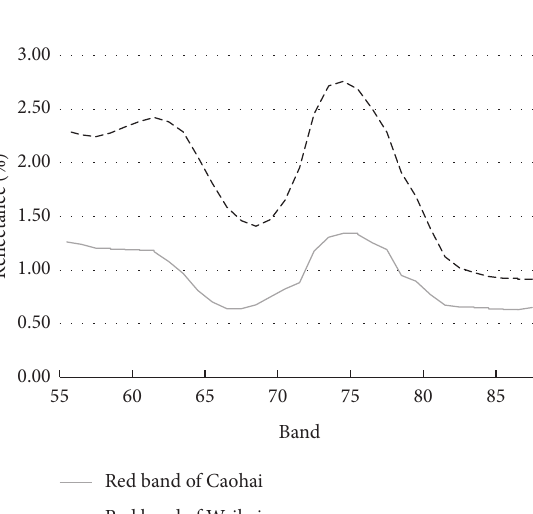
Figure 3: Flowchart.